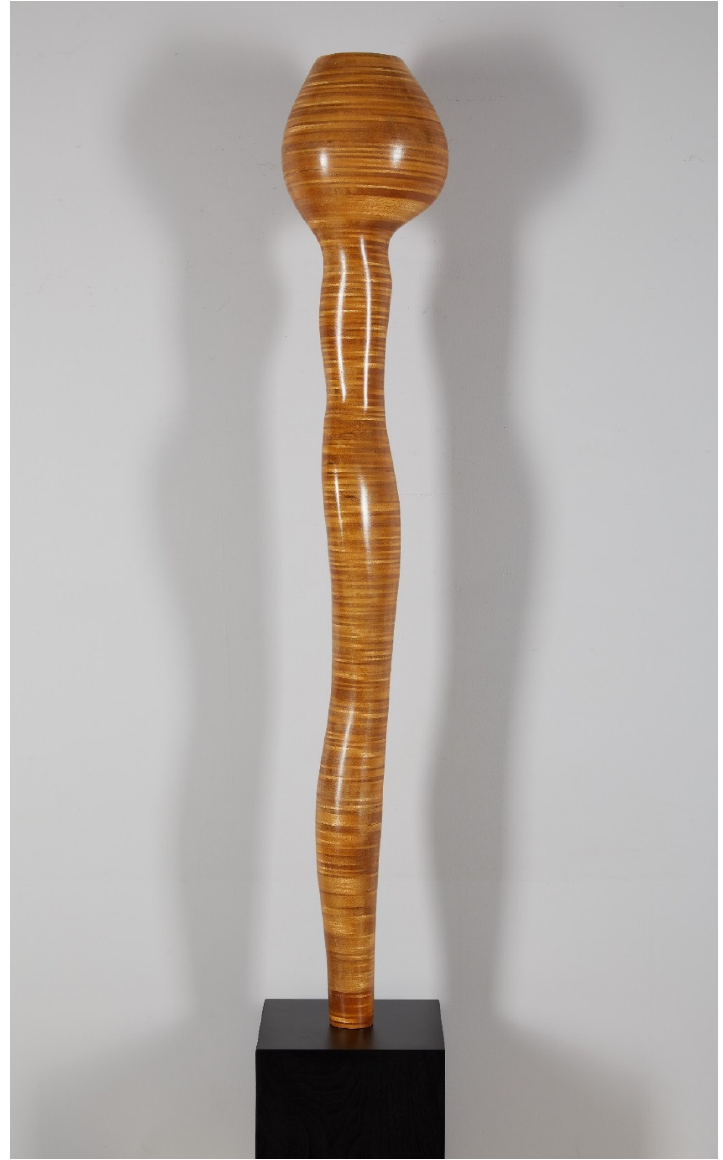
Figure 8. Robert Mallary, QUAD III , 1969. Plywood, metal, and resin on plywood base. Collection of Tate © Estate of the artist. Image courtesy of Mayor Gallery, London.